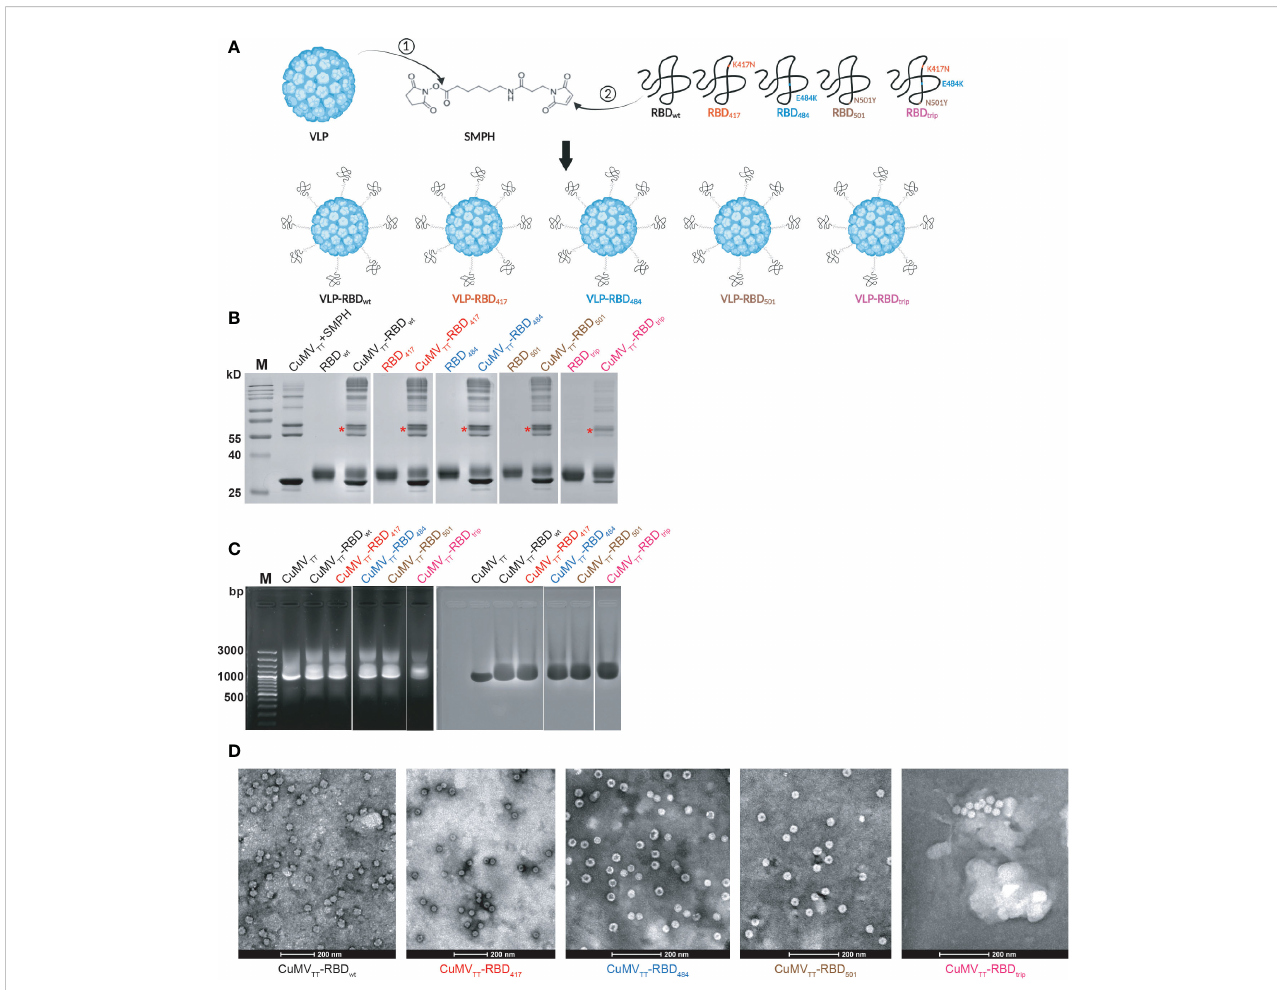
FIGURE 1 CuMV TT -based vaccines were generated by covalently linking RBD wt , RBD 417 , RBD 484 , RBD 501 , and RBD trip to CuMV TT via SMPH (A) ; CuMV TT -based vaccines were examined in SDS-PAGE gel to con fi rm the coupling ef fi ciency (B) , agarose gel for RNA content (C) , transmission electron microscopy for intact viral shape (D) . The monovalent coupling was indicated by